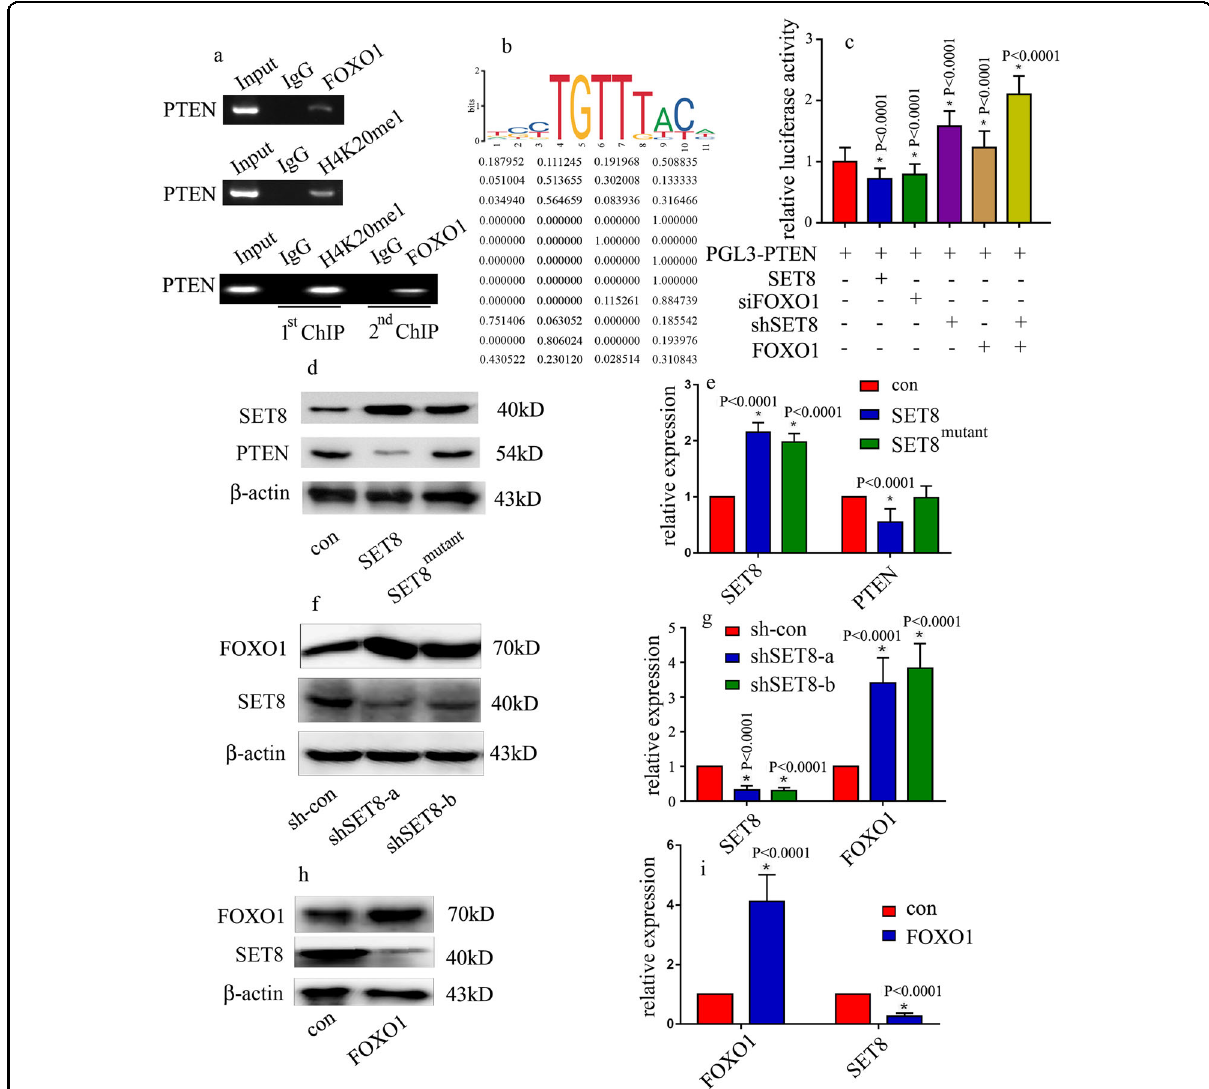
Fig. 6 SET8 interacted with FOXO1 to modulate PTEN expression in HUVECs. a H4K20me1 and FOXO1 were enriched in the PTEN promoter region. The re-ChIP assay results indicated that H4K20me1 and FOXO1 occupied the same region of the PTEN promoter. b The putative FOXO1- binding site of PTEN. The motif logo and position weight matrix are shown in the upper and lower panels, respectively. c PTEN promoter activity was detected by luciferase reporter assays. * P < 0.05, compared with the control group. d Results from the western blot analysis of SET8 and PTEN expressions in HUVECs compared with HUVECs serving as the control or those overexpressing SET8 or mutant SET8 R259G . e Results from the qPCR analysis of SET8 and PTEN expressions in HUVECs compared with HUVECs serving as the control or those overexpressing SET8 or mutant SET8 R259G . f Results from the western blot analysis of SET8 and PTEN expressions in HUVECs compared with HUVECs serving as the control or those transfected with shSET8. g Results from the qPCR analysis of SET8 and PTEN expressions in HUVECs compared with HUVECs serving as the control or those transfected with shSET8. h Results from the western blot analysis of SET8 and PTEN expressions in HUVECs compared with HUVECs serving as the control or those overexpressing FOXO1. i Results from the qPCR analysis of SET8 and PTEN expressions in HUVECs compared with HUVECs serving as the control or those overexpressing FOXO1. * P < 0.05, compared with the control group, n =